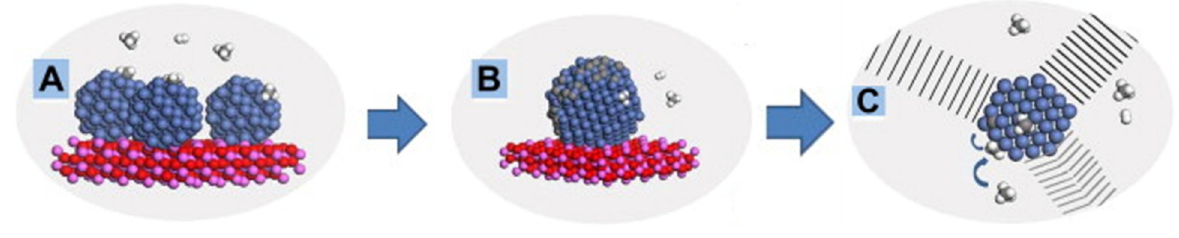
Figure 19. Schematic diagram of OCNFs’ formation during methane cracking process [81]. ( A ) Adsorption of methane molecules on catalyst particles; ( B ) The formation of nuclei and hydrogen release. ( C ) OCNFs’ growing from one metal particle.